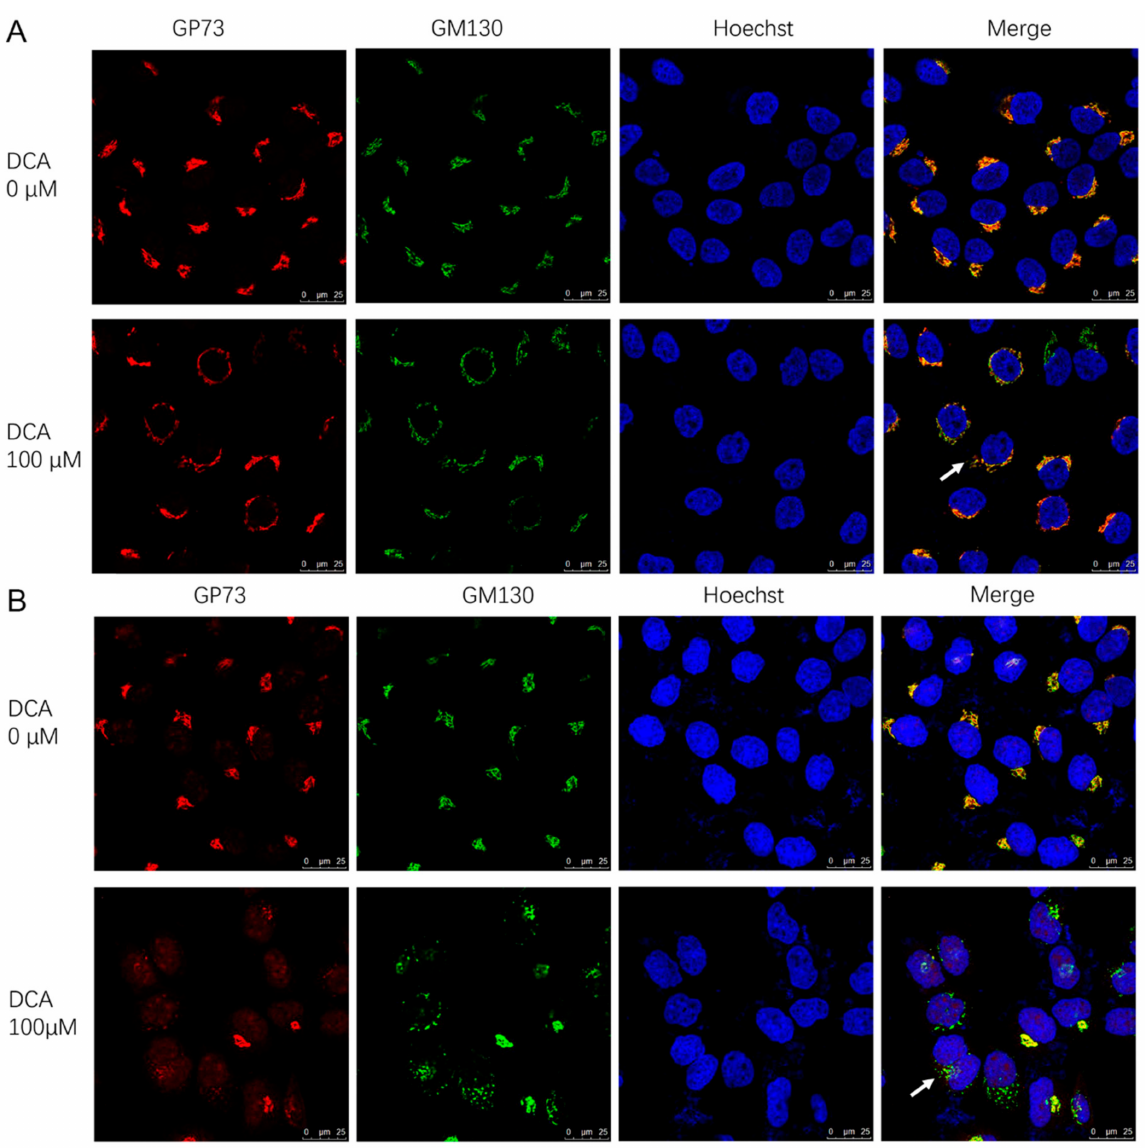
Figure 6. Deoxycholic acid (DCA) converts the Golgi into ministacks in Huh-7 and SMMC7721 cells. Huh-7 cells ( A ) and SMMC7721 cells ( B ) were treated with 100 µ M DCA for 72 h and co-stained for GP73 (red) and cis -Golgi marker GM130 (green); nuclei were identified with Hoechst (blue). Arrows denote the